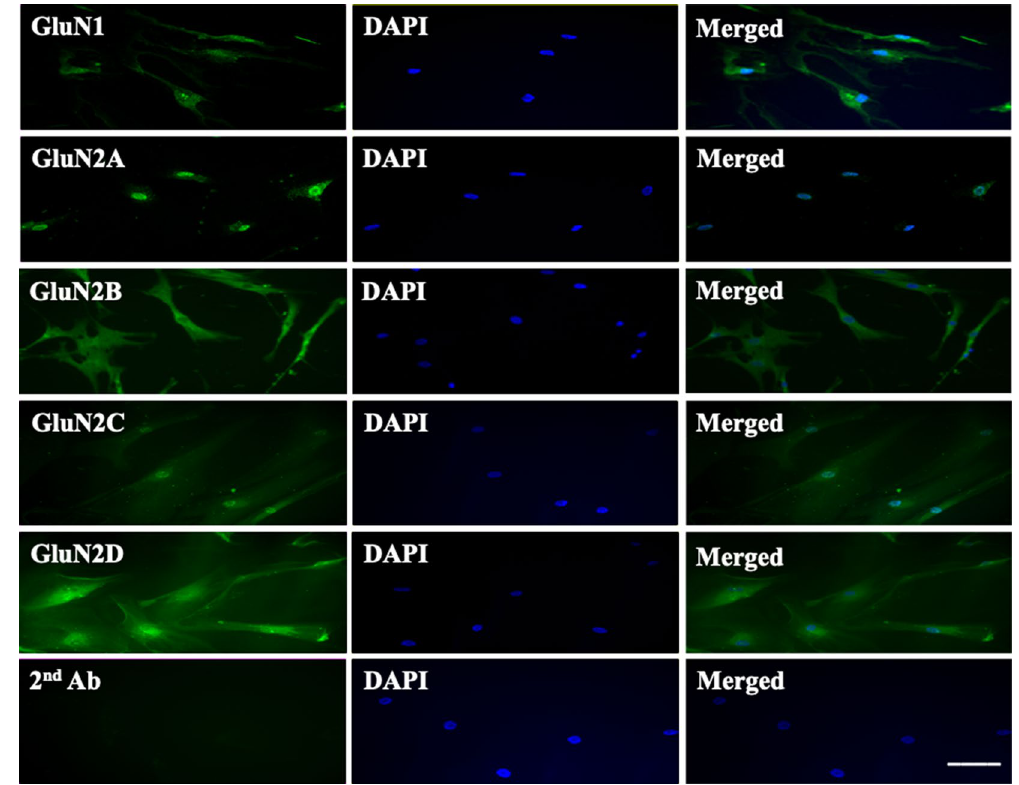
Figure 3. NMDA receptor expression in cultured HPASMCs. Immunofluorescence staining was performed on permeabilized HPASMCs. Network-like immunoreactive staining was observed for both GluN1 and all four GluN2 (2A–D) subunits. Control experiments with primary antibody omitted showed no immunoreactivity. Results are representative images taken from at least three separate experiments. Scale bar = 50